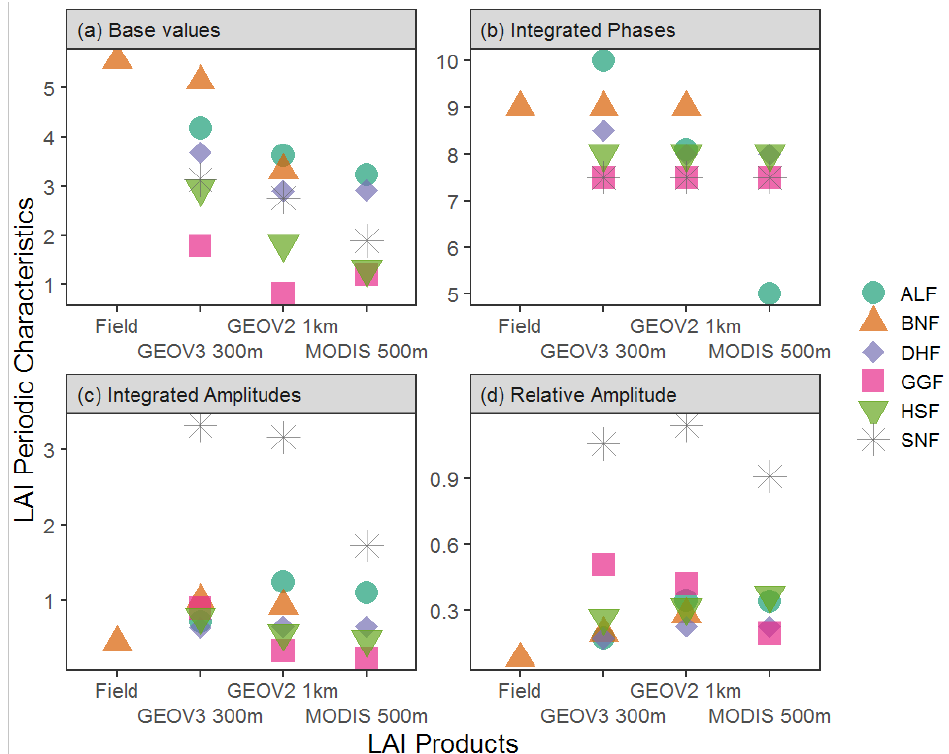
Figure 5. Periodic characteristics of the LAI time series from 2005 to 2017 for different sites. ( a ): Baseline values of the LAI time series; ( b ): Phase of the LAI time series; ( c ): Amplitude of the LAI time series; ( d ): Relative amplitude of the LAI time series. Point colors and shapes represent different sites.